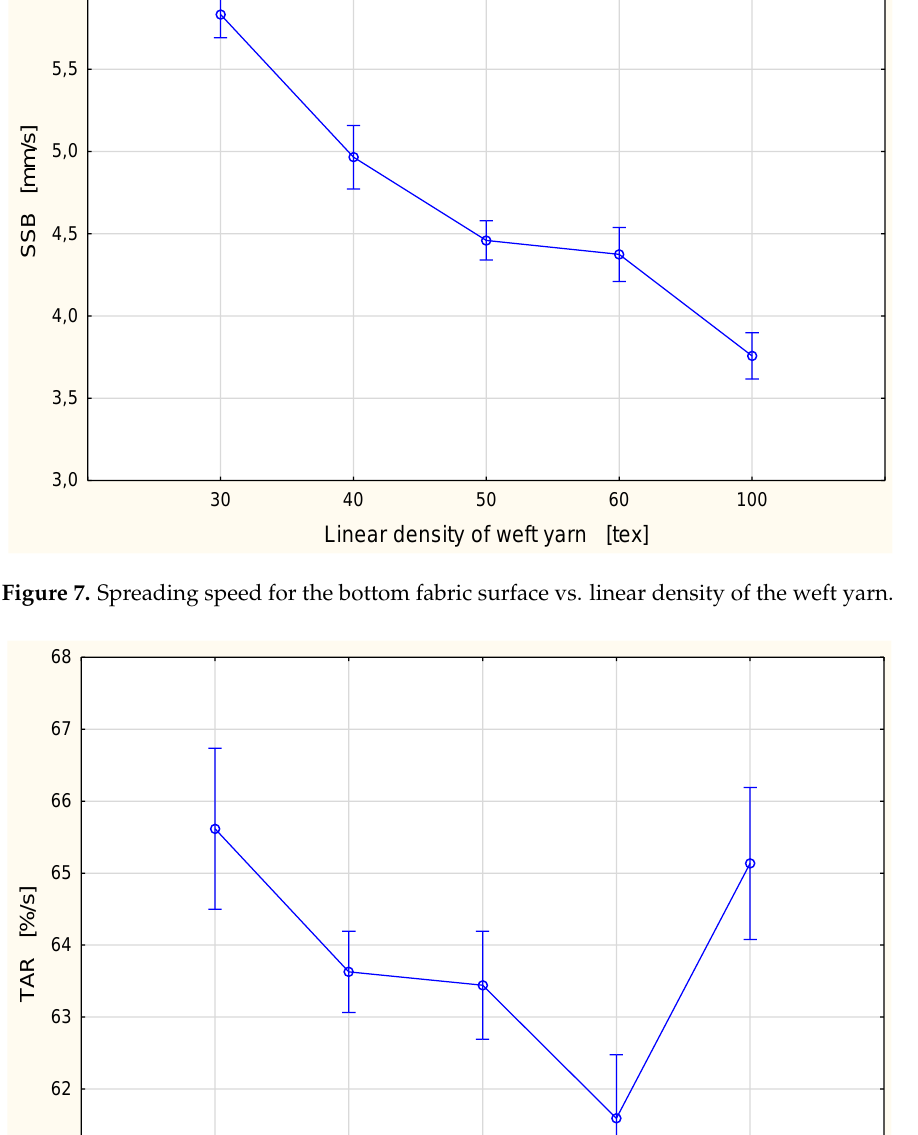
Figure 6. Spreading speed for the top fabric surface vs. linear density of the weft yarn.